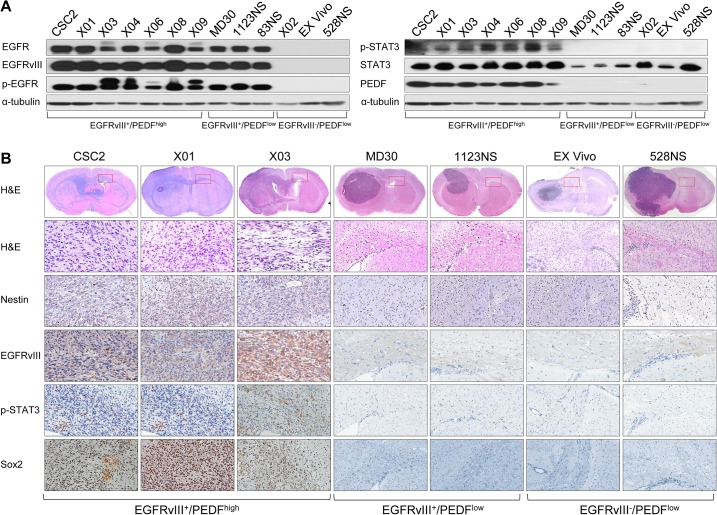
EGFRvIII/STAT3/PEDF signaling in GSCs.(A) IB analysis of EGFR, EGFRvIII, p-EGFR, p-STAT3, STAT3, and PEDF (in medium) in 13 GSCs. α-tubulin was used as a loading control. EGFRvIII+/PEDFhigh GSCs are CSC2, X01, X03, X04, X06, X08, and X09 cells. EGFRvIII+/PEDFlow GSCs are MD30, 1123NS, and 83NS cells. EGFRvIII-/PEDFlow GSCs are X02, Ex Vivo, and 528NS cells. (B) Histopathology of Balb-c/nu mouse brain tissue was orthotopically injected with three representative types of GSCs (A). Upper panel is hematoxylin and eosin (H&E) staining of the whole brain. Red box indicates a site of corpus callosum far from the injection site. This site was stained by H&E, Nestin, EGFRvIII, p-STAT3, and Sox2.